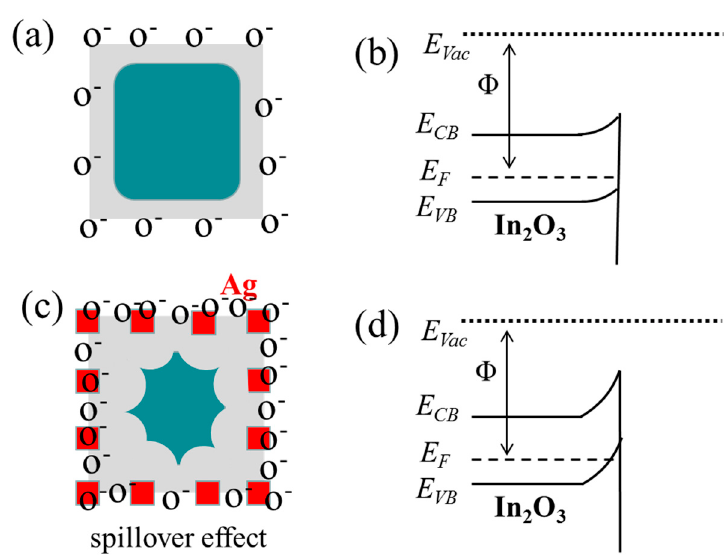
Figure 8. The schematic diagram ( a ) and energy band diagram ( b ) of pure In 2 O 3 ; the schematic diagram ( c ) and energy band diagram ( d ) of 5 mol % Ag-modified In 2 O 3 . E CB and E VB are the conduction band and valence band level, E vac and E F represent the vacuum level and Fermi level.